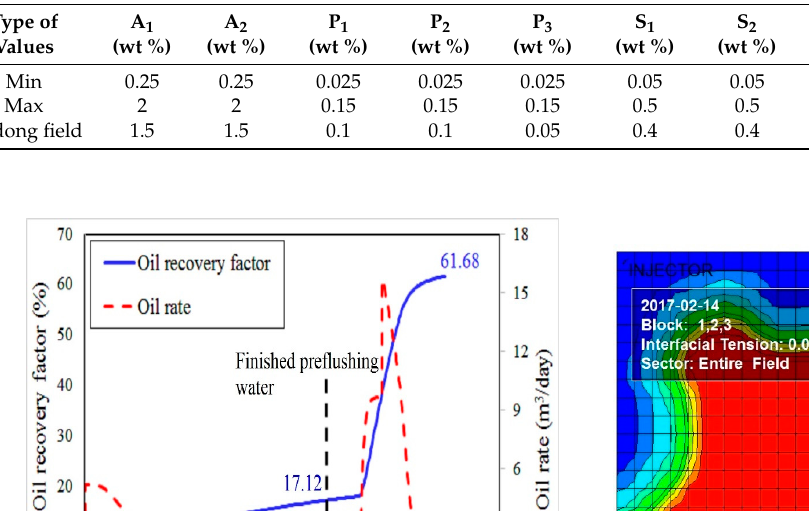
Table 3. Thresholds of the data points for either input or output values and practical values of the real project. Type of